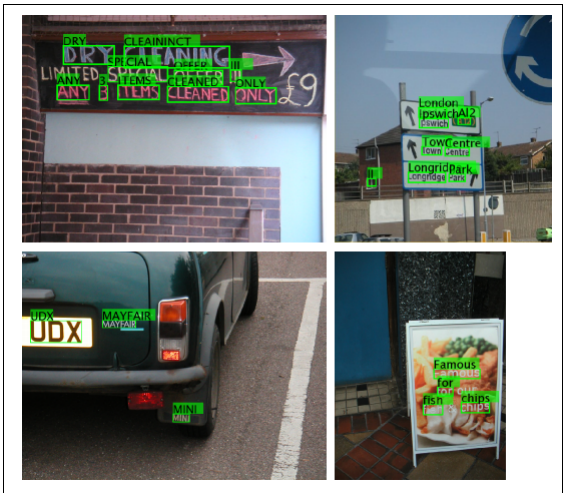
Figure 5. Optical character recognition in real